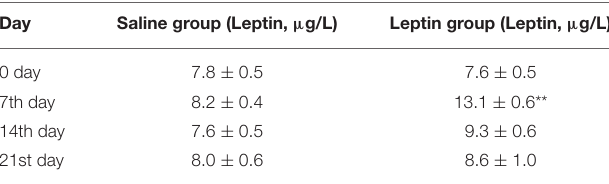
TABLE 2 | Blood plasma levels of leptin in response to chronic application of saline and